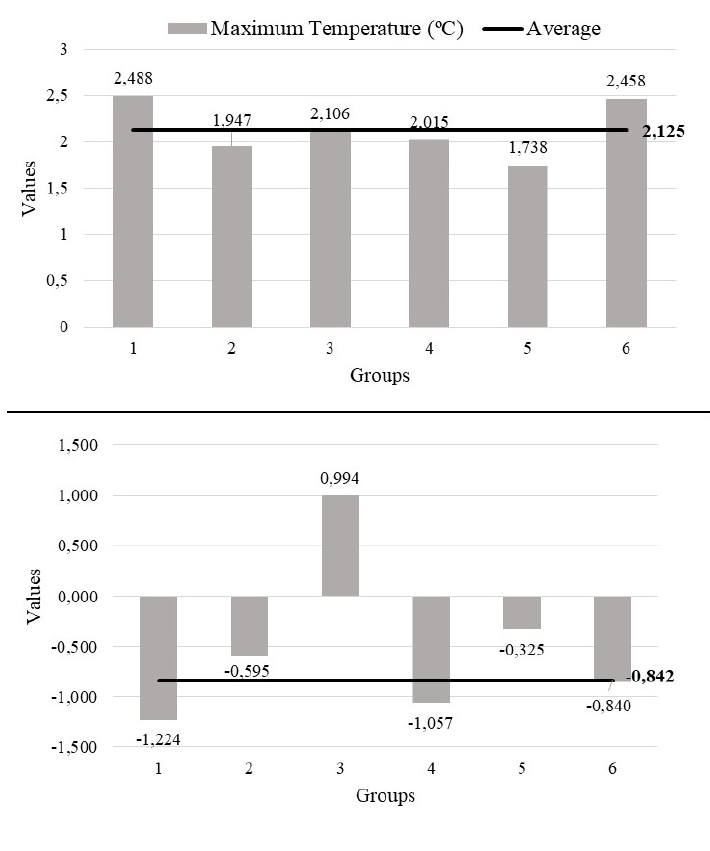
Figure 2. RMSE (a) and MB (b) values for the study area - maximum temperature